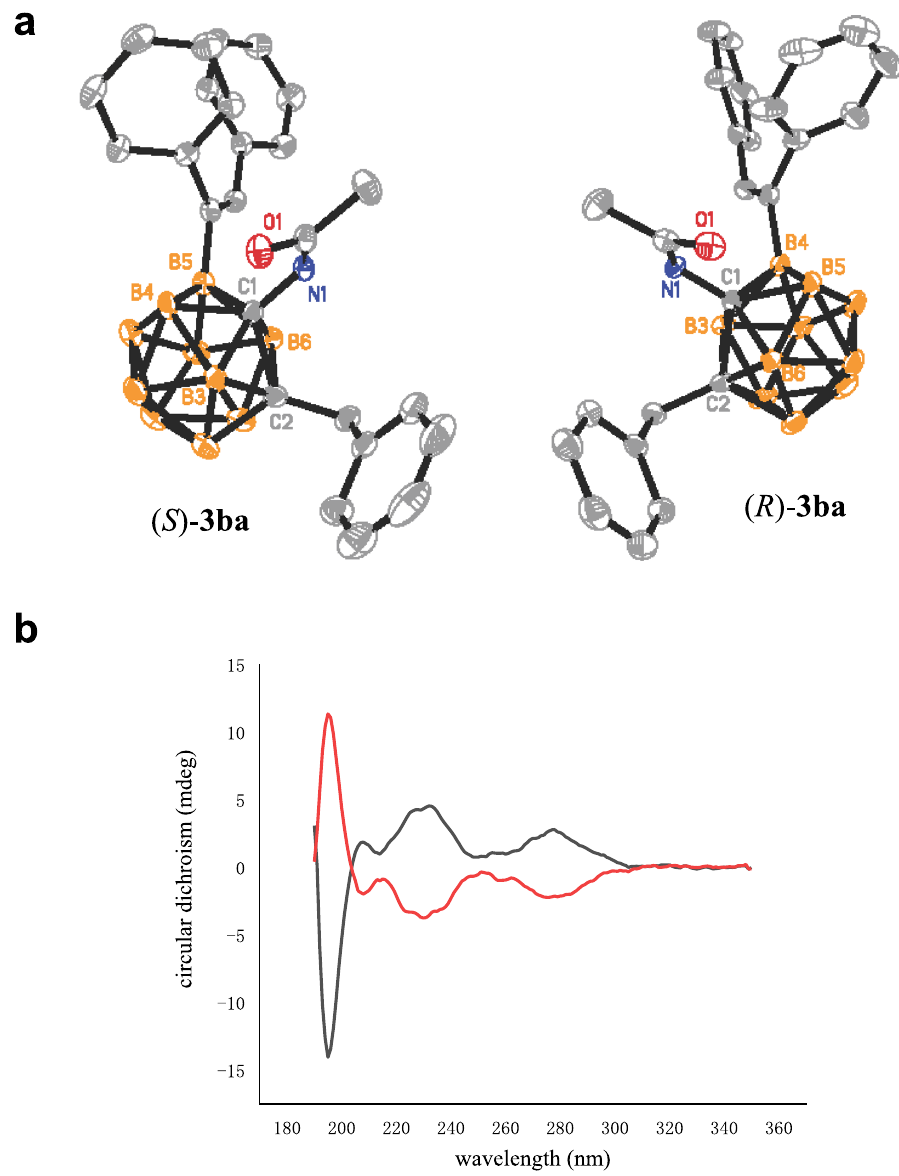
Fig. 2 The chirality of B(4/5)-alkenylated o -carborane. a Molecular structures of ( S )- 3ba and ( R )- 3ba . b CD Spectra of ( S )- 3ba (black) and ( R )- 3ba (red) in MeCN ( c = 0.1